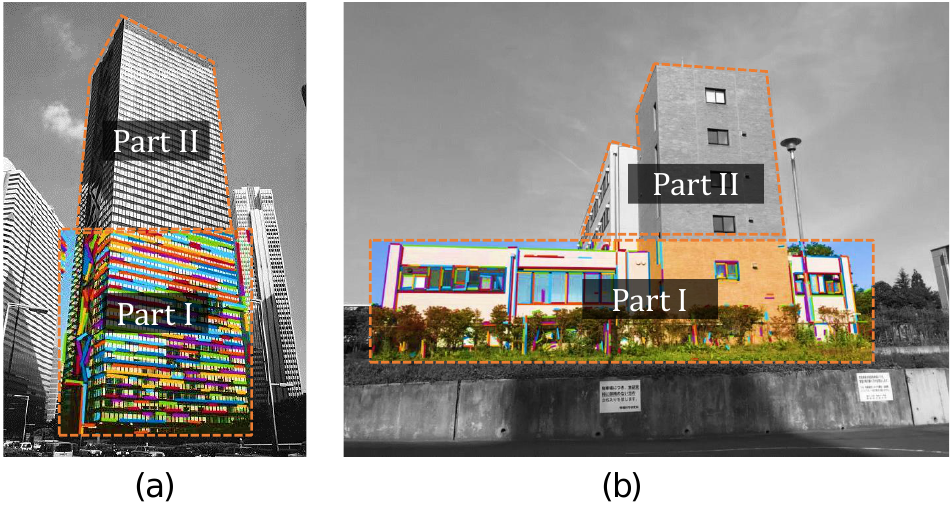
Figure 2. Examples of image segmentation (Line detection by [21]): ( a ) target building itself as part I; ( b ) structures from surrounding environments as part